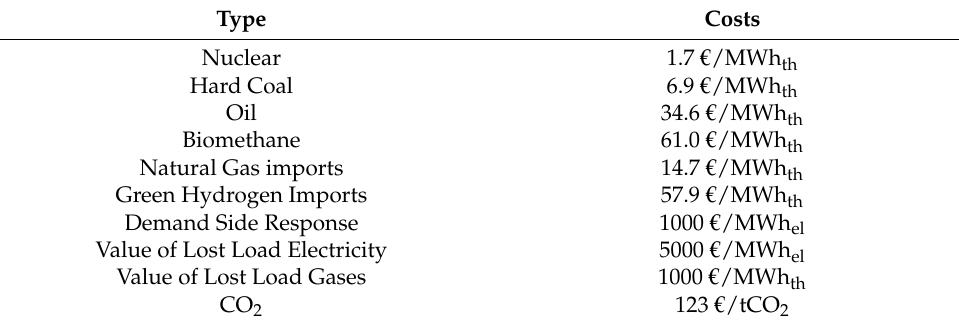
Table 4. Costs assumption (modified based on [50,54]).